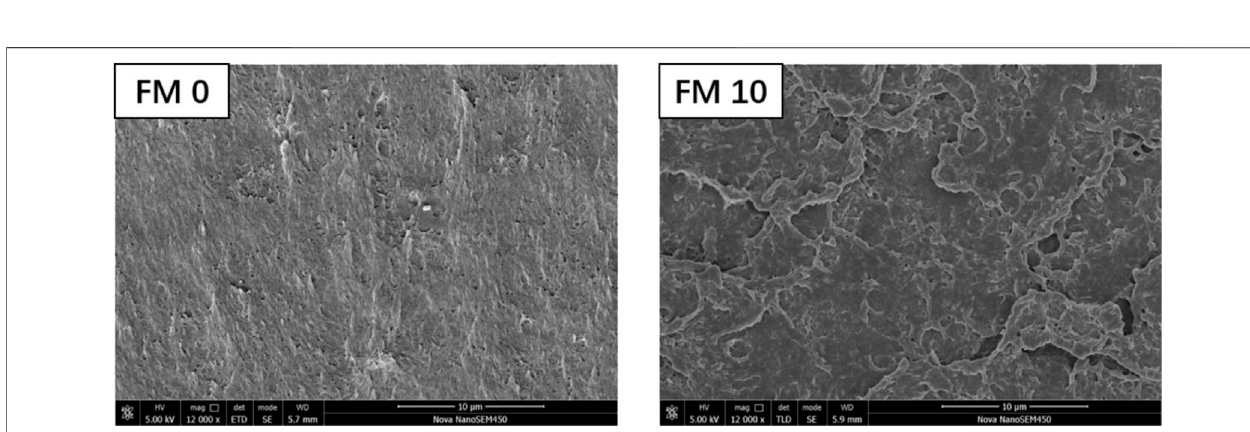
FIGURE 1 | Schematic representation of the strip-line method for measuring high-frequency dielectric properties.